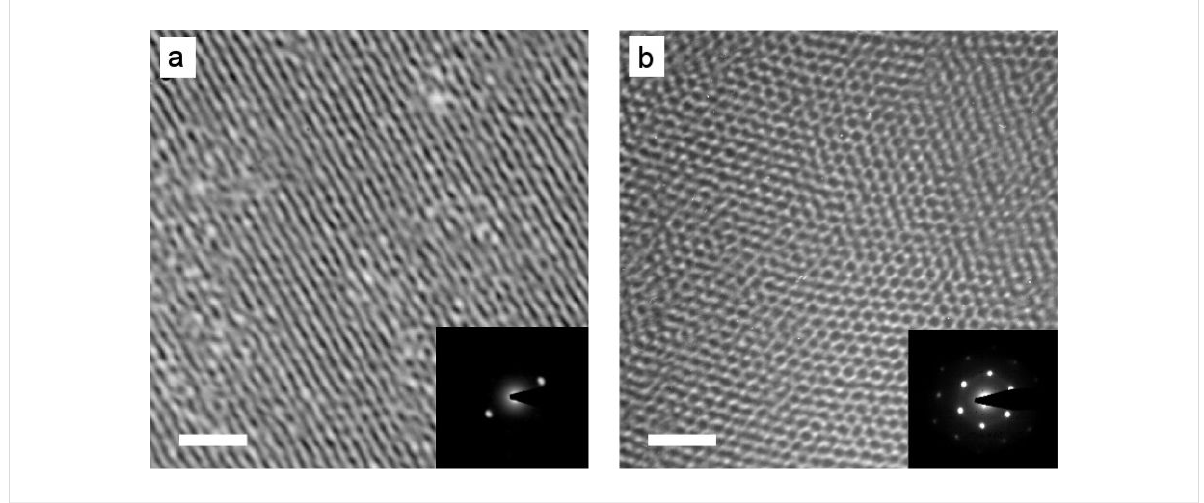
Figure 17: TEM images of thin films of the phase of Au@C 12 /13 recorded with the beam (a) parallel to the plane and (b) parallel to the [001] axis. Scale bar = 20 nm. Insets show the corresponding electron-diffraction patterns. Reprinted with permission from [65]. Copyright 2009 Wiley- VCH